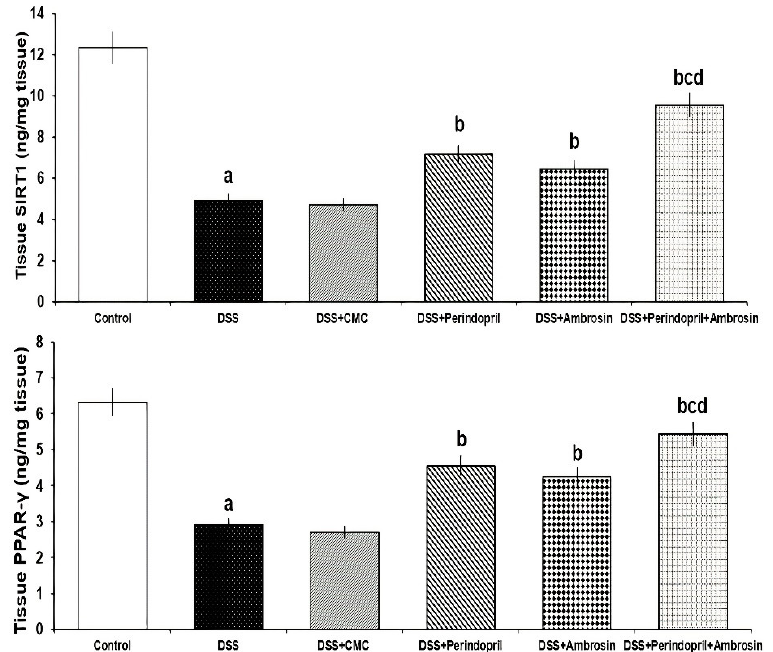
Figure 2. Effect of perindopril with or without ambrosin on SIRT1/PPAR-γ signaling in the colonic tissues of DSS-treated mice (Mean ± SD); where “a” denotes significant vs. the control group ( p -value less than 0.05); “b” denotes significant vs. DSS group (p-value less than 0.05); “c” denotes significant vs DSS + perindopril group ( p -value less than 0.05); “d” denotes significant vs DSS + ambrosin group ( p -value less than 0.05).